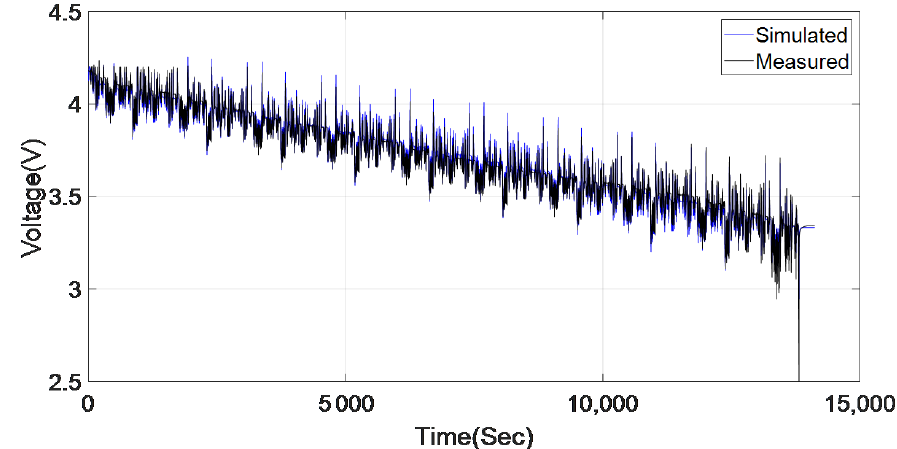
Figure 8. Measured and simulated model output.